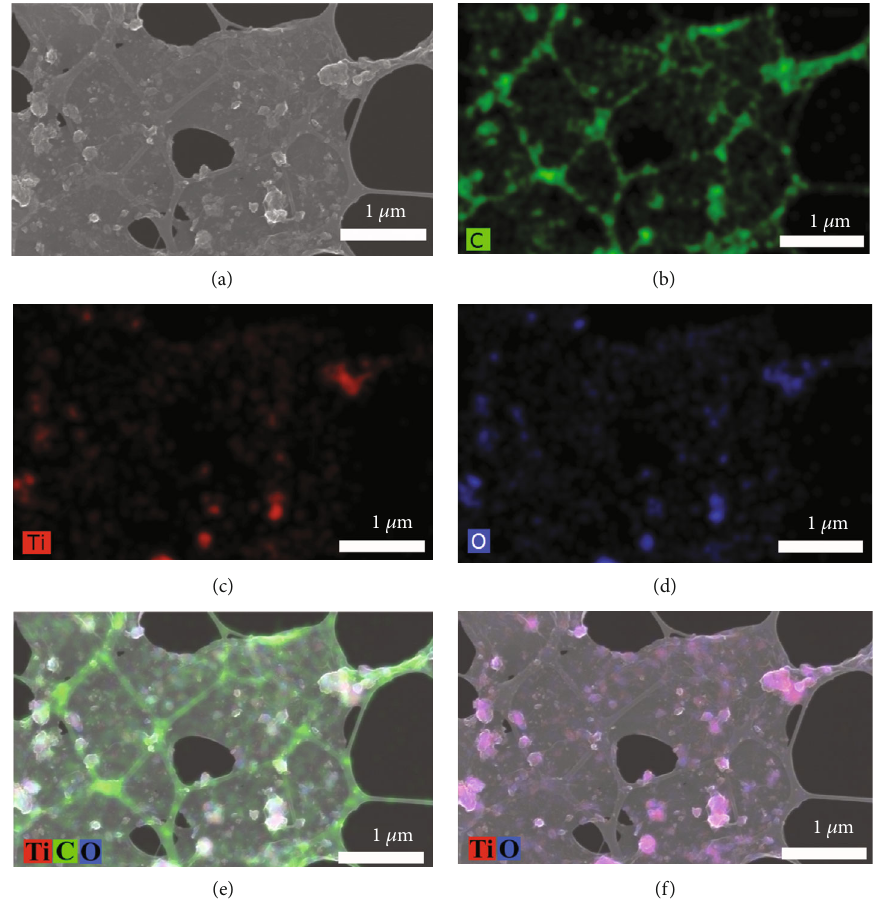
Figure 4: EDS elemental analysis for C3 compound. Di ff erent elements is displayed and color, respectively a)GO sheet with TD nanoparticles, b)identi fi cation of carbon as a green color, c) titanium present in the GO as a red color,(d) oxygen as a blue (e) identi fi cation elemental Ti, C and O, f) Ti and elemental identi fi cation